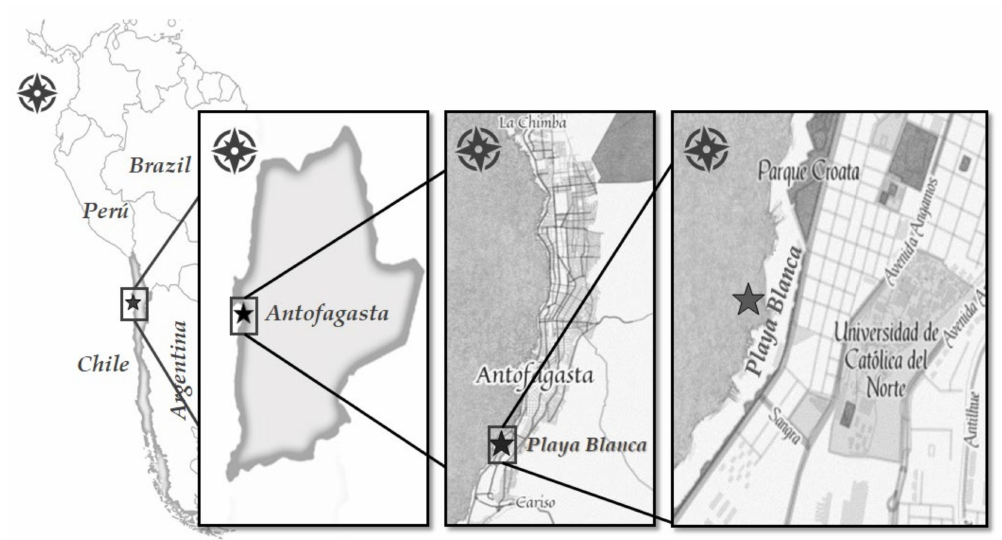
Figure 2. Location of the beach under study.